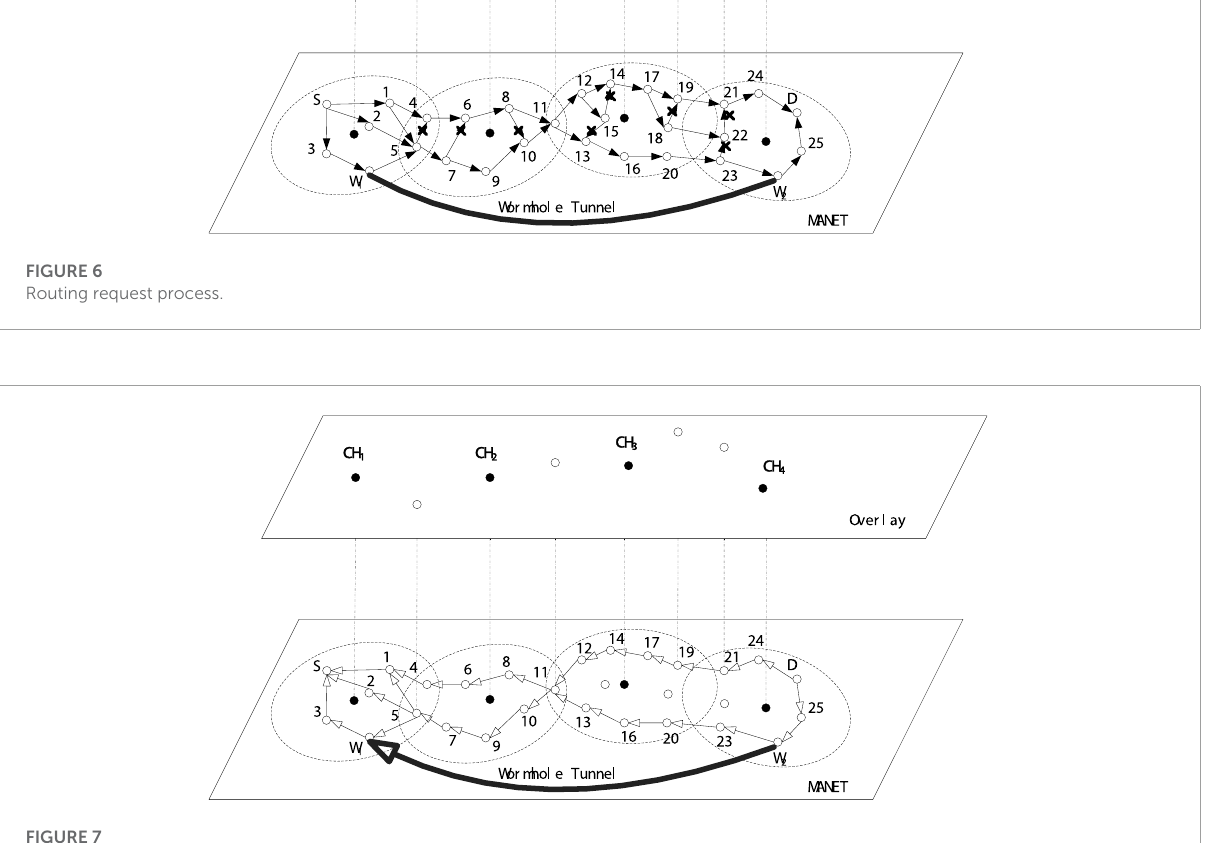
FIGURE 7 Routing reply